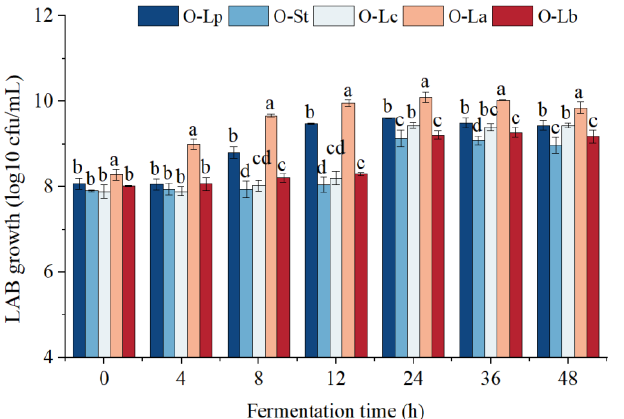
Figure 1. Growth curves of five strains at different incubation time in oat substrate. Different letters indicate significant differences among different strains a given fermentation time ( p < 0.05). O-Lp, sample fermented with L. plantarum ; O-La, sample fermented with L. acidophilus ; O-Lc, sample fermented with L. casei ; O-Lb, sample fermented with L. bulgaricus ; O-St, sample fermented with S. thermophilus. h, hours; cfu, colony forming units; LAB, Lactic acid bacteria.